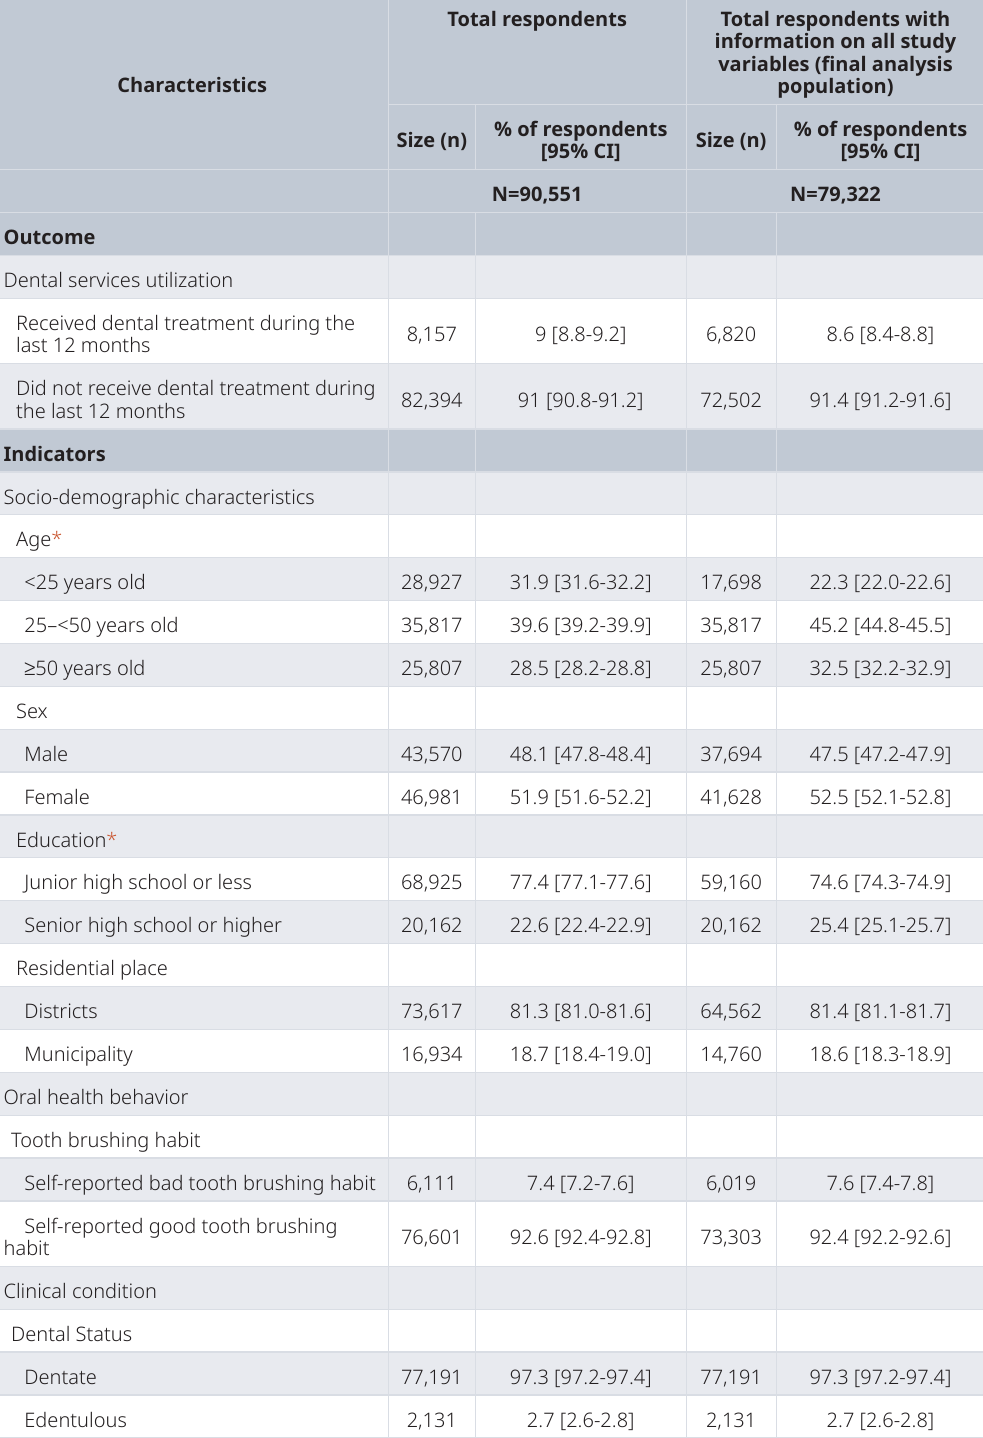
Table 1. Demographic and background characteristics of the study participants.